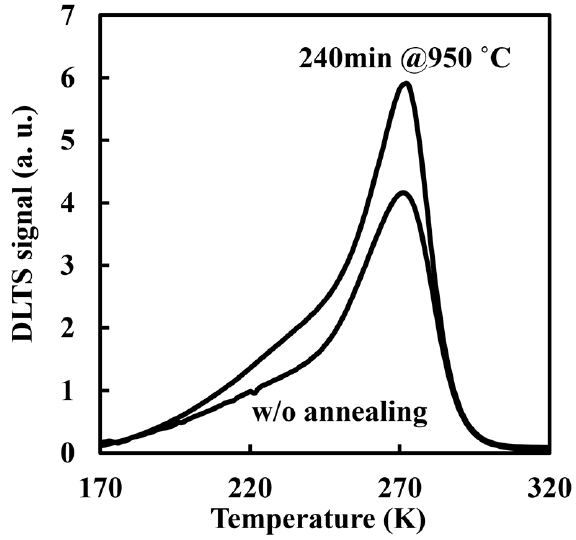
Figure 3. The increase of DLTS signal intensity by the 950 °C pre-annealing. The relationship between the annealing time and E1 defect concentrations in the Cz and Fz Si crystals is shown in Figure 4. The signal intensity of Cz-Si increased as the annealing time increased. This indicates that oxygen precipitation might be related to the structure of RPD-induced defects. In contrast, in the case of Fz-Si, the increase of E1 defect signal intensity was very slight with increasing annealing time.